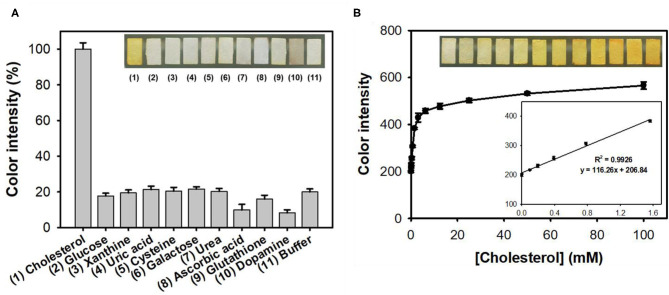
(A) Real images and the corresponding color intensities of the selective colorimetric detection of cholesterol using paper strips incorporating nanoceria and ChOx. A 10 mM concentration of cholesterol was used, while 100 mM of other substrates was used in the experiments. (B) Real images, dose-response curve, and the corresponding linear calibration plots for cholesterol determination using paper strips incorporating nanoceria and ChOx. The error bars represent the standard deviation of three independent measurements.